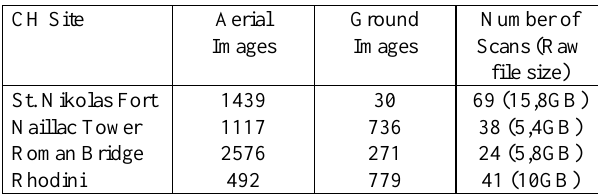
Table 1 . Quantitative details of the acquired data for the 3D